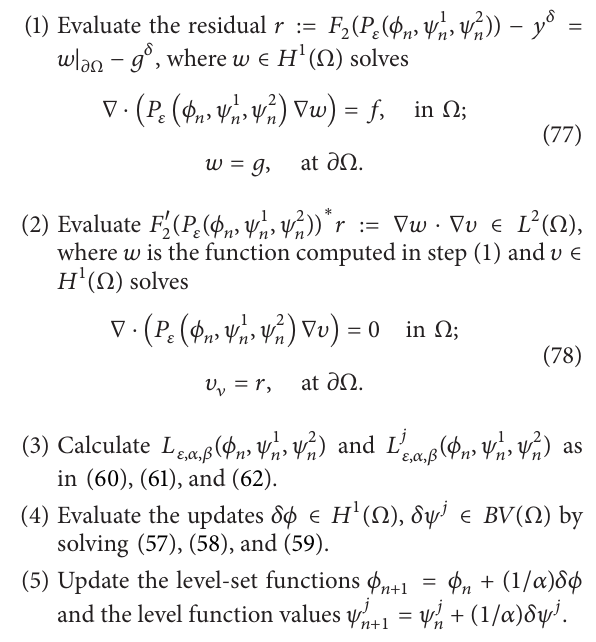
Algorithm 23 (an explicit algorithm based on the proposed level-set iterative regularization